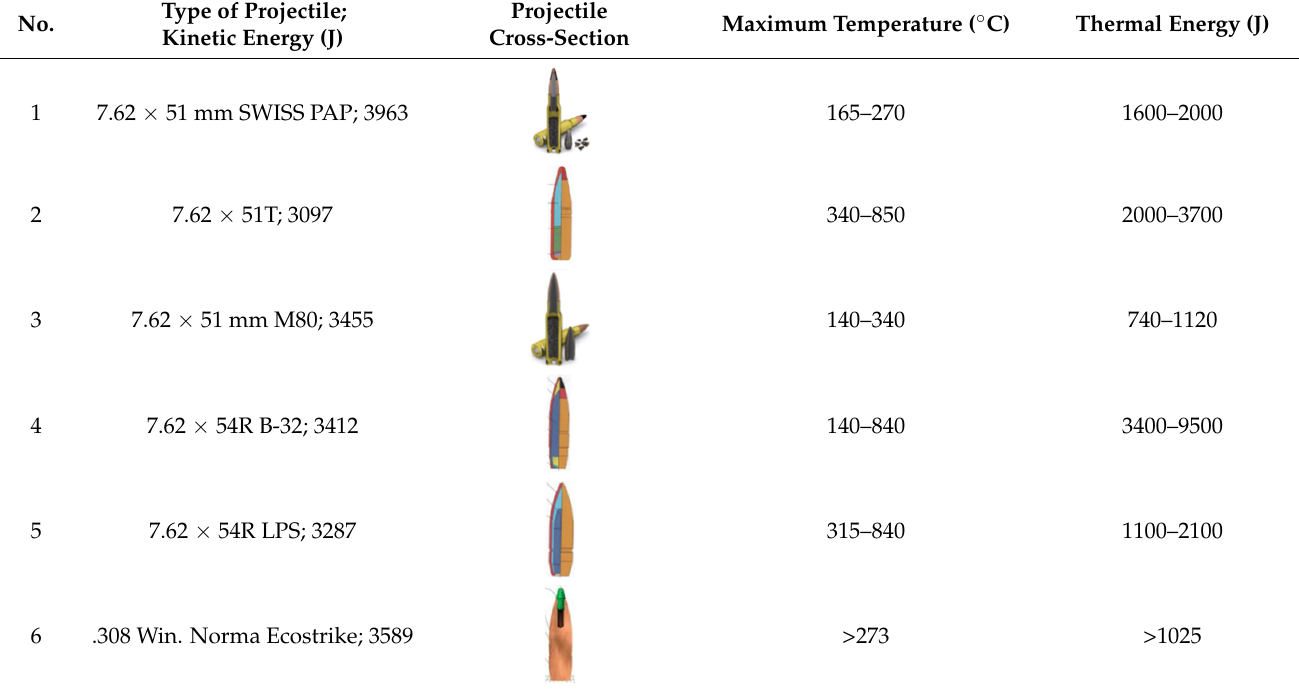
Table 2 presents the results of calculating thermal energy during projectile ricochet ‐ ting on the Armox 600 armour plate, and Table 3 presents the calculation results of thermal energy during projectile ricochetting on the surface of non ‐ metallic components. Table 2. Thermal energies during projectiles ricochetting on the Armox 600 armour plate.